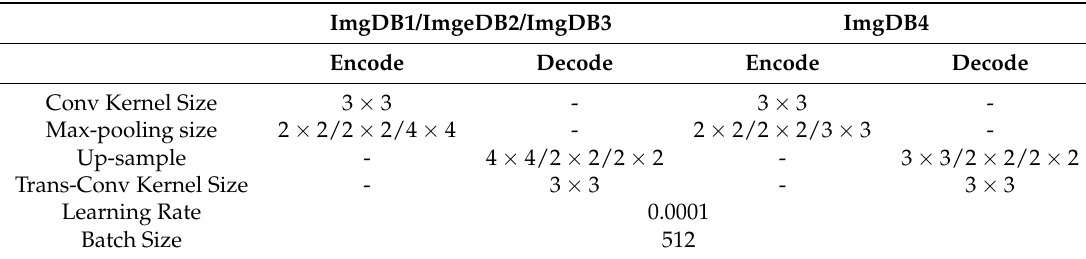
Table 1. Configuration of the deep convolutional auto encoder